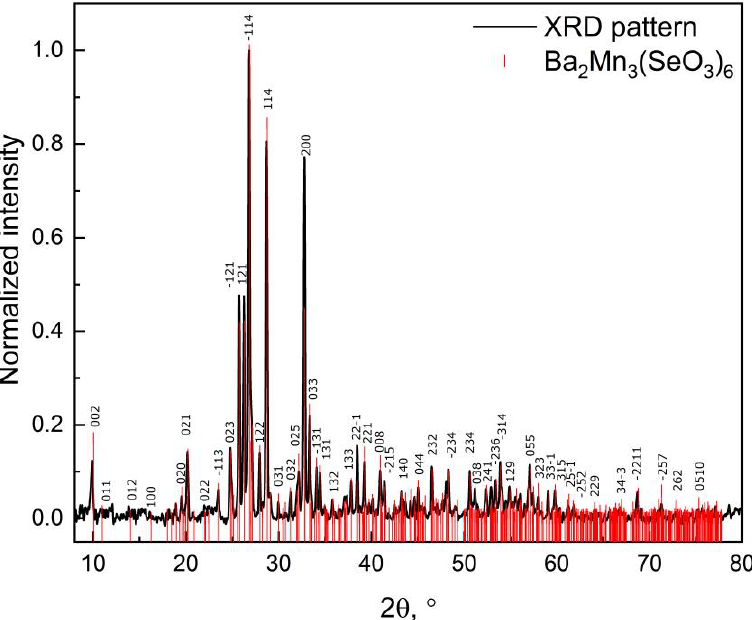
Figure 1. Diffraction pattern obtained for powder samples of Ba 2 Mn 3 (SeO 3 ) 6 . The red lines are shown as the reference for peak positions and indexing (some of the indexes were omitted due to high density of peaks).